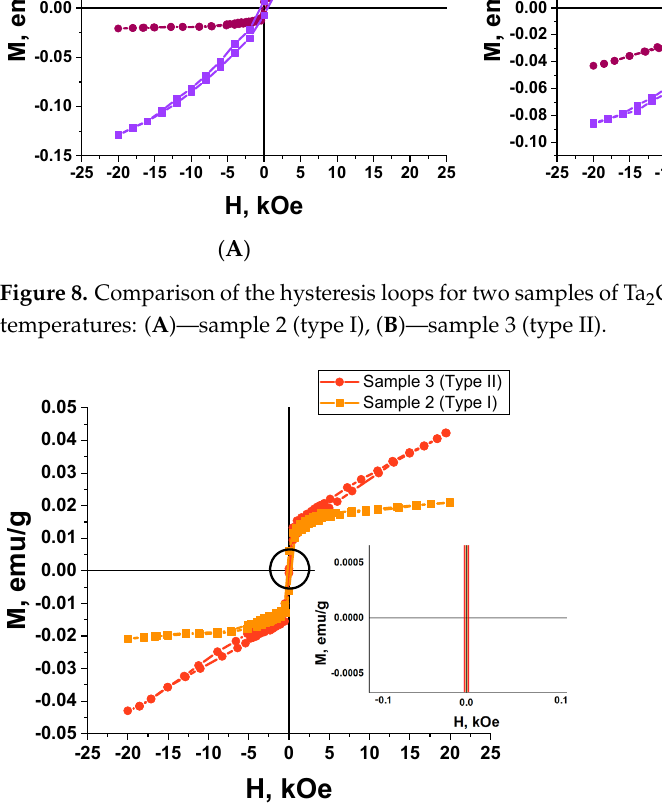
Figure 9. Comparison of the hysteresis loops for two samples of the Ta 2 O 5 pillars with Ni tips at 300 K.